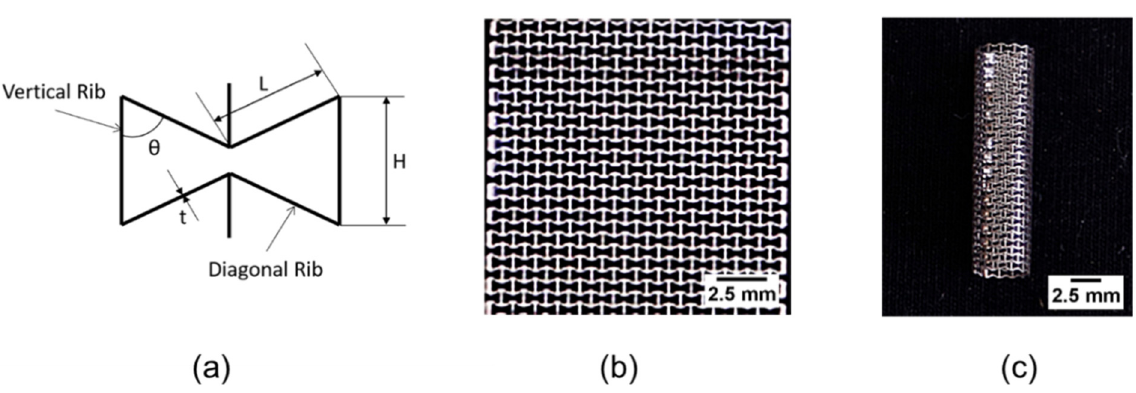
Figure 2. ( a ) Unit-cell structure for re-entrant geometry; ( b ) repeating unit-cell pattern femtosecond micromachined laser-cut stainless-steel metal plate; and ( c ) fabricated laser-welded auxetic stent.